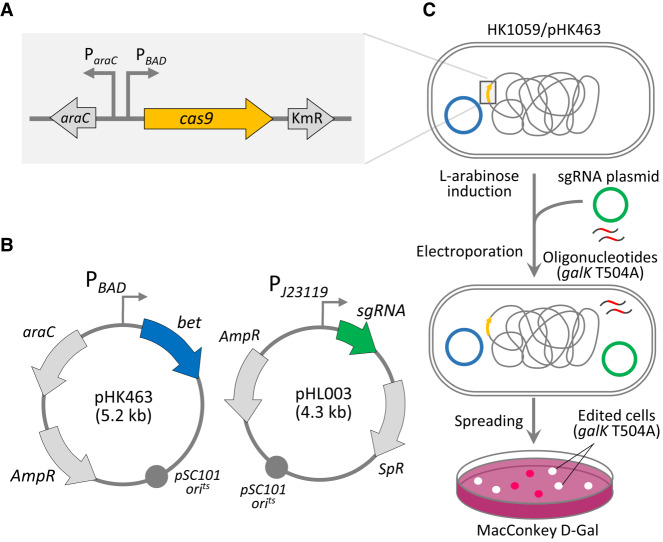
Schematic representation of bacterial genome-editing. (A) Chromosomal construction of cas9 downstream from the PBAD promoter, which forms an L-arabinose-inducible cas9 gene. (B) Construction of plasmids. Lambda bet expression vector (pHK463) was derived from pKD46 plasmid. The sgRNA expression plasmid (pHL003) harbors a temperature-sensitive origin for iterative genome engineering. (C) Genome editing. Mutagenic oligonucleotides carrying galK T504A and sgRNA plasmids were electroporated into E. coli cells overexpressing Cas9 and Bet proteins by L-arabinose induction. Recovered cells were spread on MacConkey agar containing D-galactose. Red/white colonies were counted for determination of galK editing efficiency.